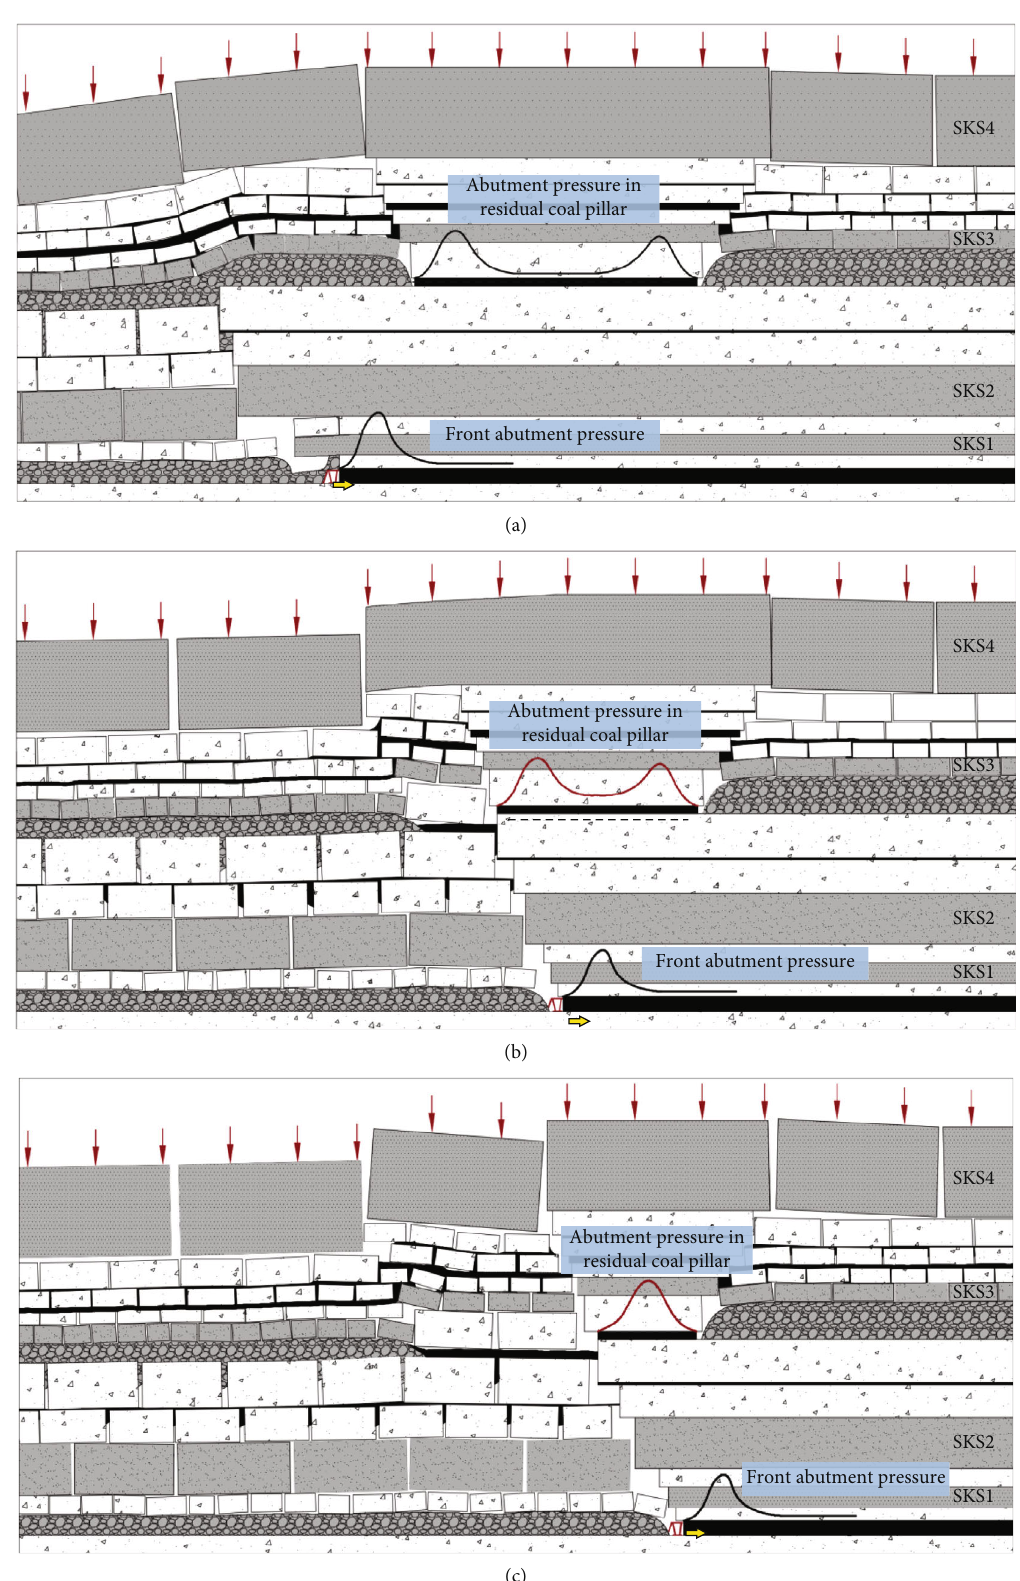
Figure 11: Evolution of THRRCPS and abutment pressure of section coal